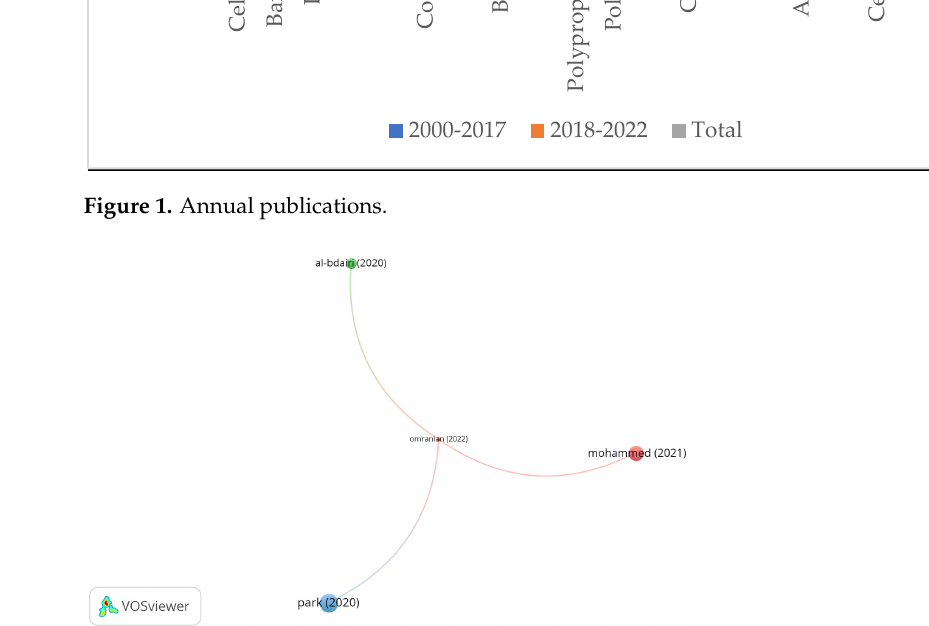
Figure 2. Network visualization of polypropylene fibers.